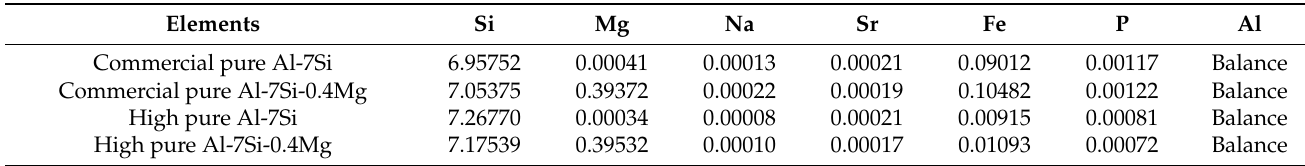
Table 1. The chemical composition (wt.%) of alloys.